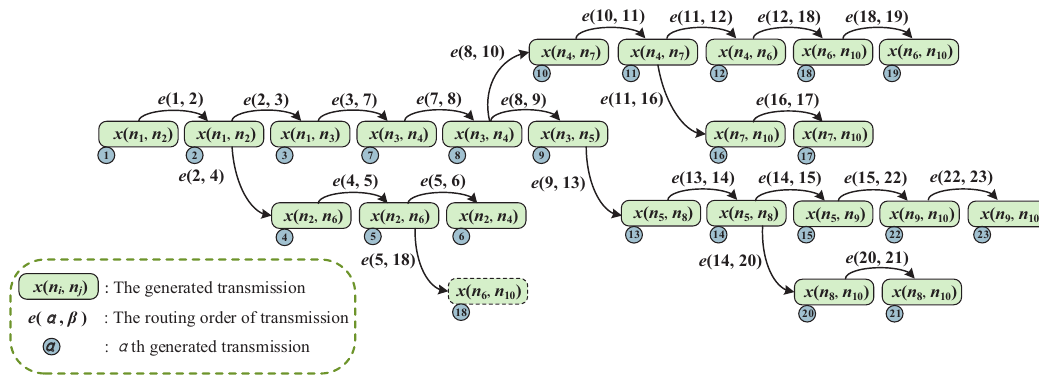
Figure 3. Generated transmissions and their transmission orders for an example